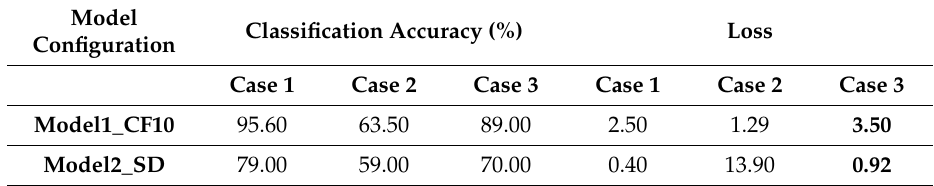
Table 4. Accuracy and loss for the CIFAR10 and ISIC 2019 (Skin disease) streams under di ff erent cases.